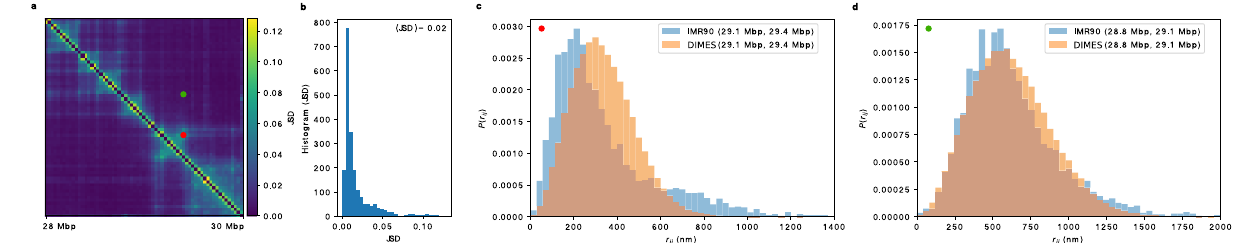
P ( r ij ). b Histogram of the JSD. c Comparison between P ( r ij ) for the pair (29.1 Mbp, 29.4 Mbp)for the experiment and the model (corresponding to the red dot in ( a )).